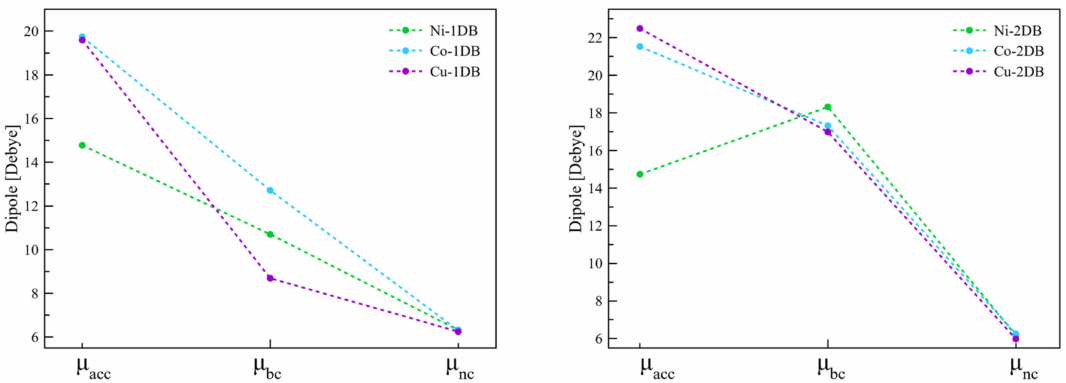
Figure 5. Depolarization shown for double interfaces. All three values were obtained for SAM- molecules in the absence of graphene layer with frozen structure. It is clearly visible that with growing intermolecular interaction the dipole moment decreases, causing significant shifts in ϕ SAM values. For exact values see Table S1.